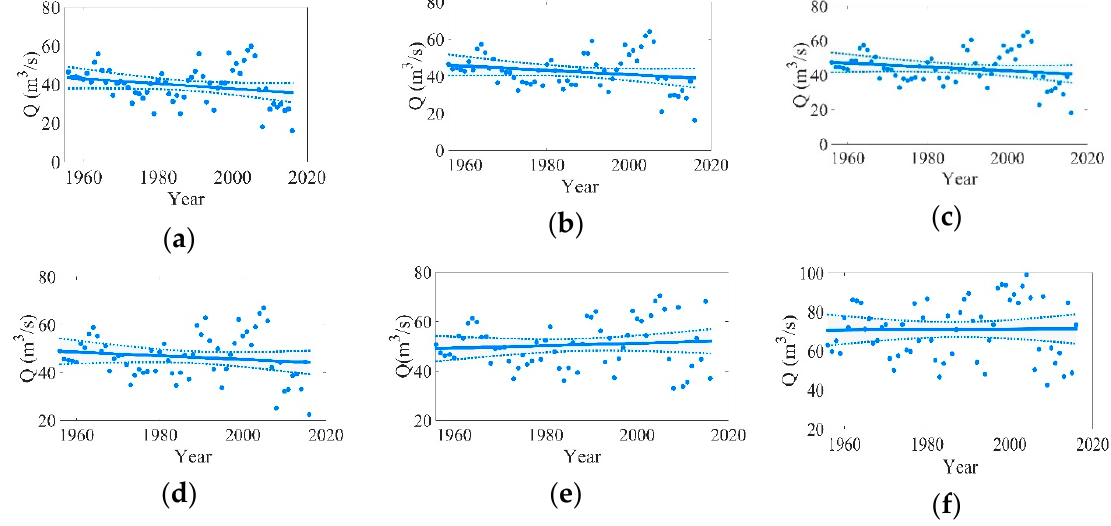
Figure 5. DLM fit for ( a ) annual minimum 1-day flow runoff, ( b ) annual minimum 3-day flow runoff, ( c ) annual minimum 7-day flow runoff, ( d ) annual minimum 30-day flow runoff, ( e ) annual minimum 90-day flow runoff and ( f ) dry season runoff at Lhasa station. The dots are the observations used in the analysis, the solid line following the observations is the DLM fit obtained by a Kalman filter. The smooth solid line is the background level component of the model with 95% probability envelope.